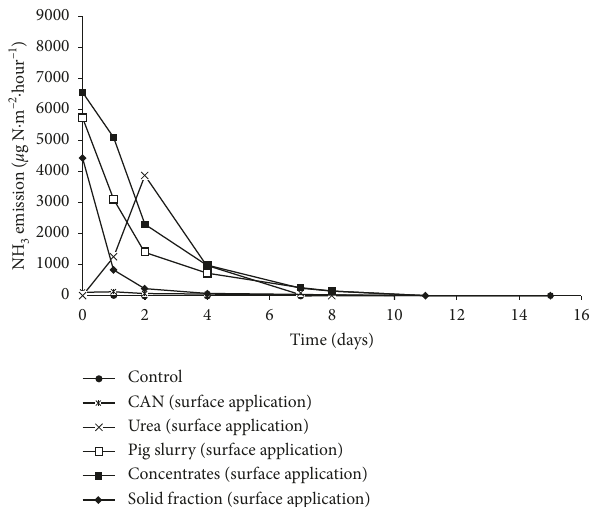
Figure 1: Ammonia emission from surface-applied manure products (average of four plants) and fertilizers applied to an arable sandy soil. After 7days, 7 mm water was added to simulate rainfall. See Table 2 for the total emissions of all treatments of this Table 2: Total ammonia and nitrous oxide emissions from different fertilizers and application techniques. Fertilizer